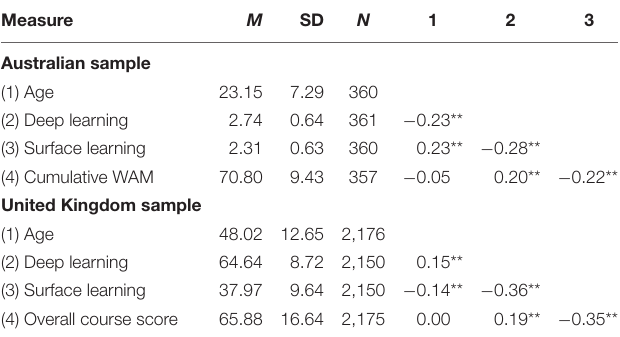
TABLE 1 | Descriptive statistics and zero-order correlation